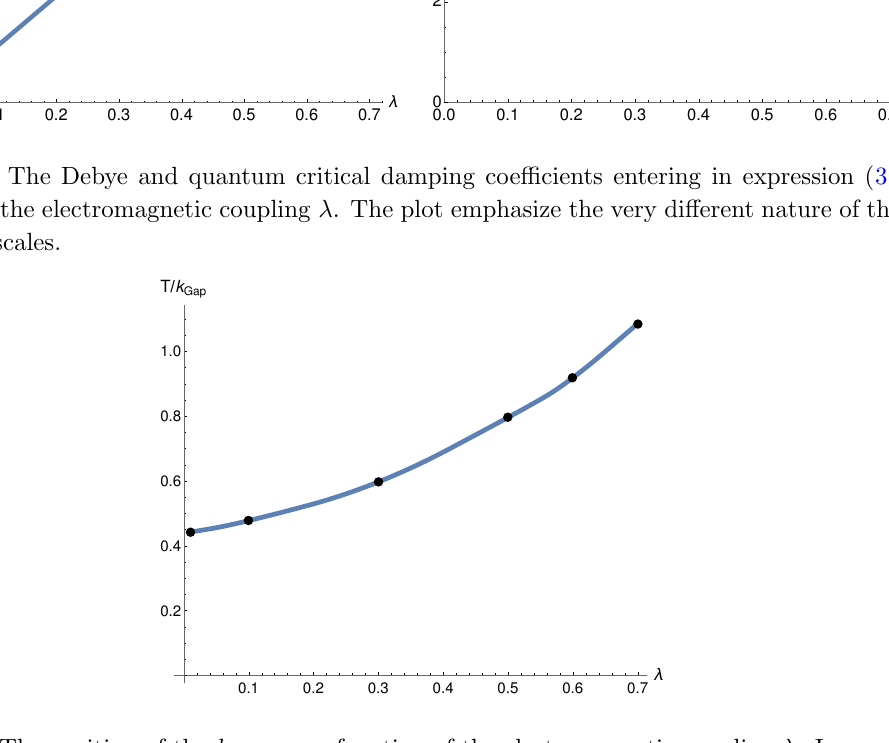
Figure 5 . The position of the k -gap as a function of the electromagnetic coupling (cid:21) . Increasing (cid:21) the k -gap appears at smaller and smaller values of